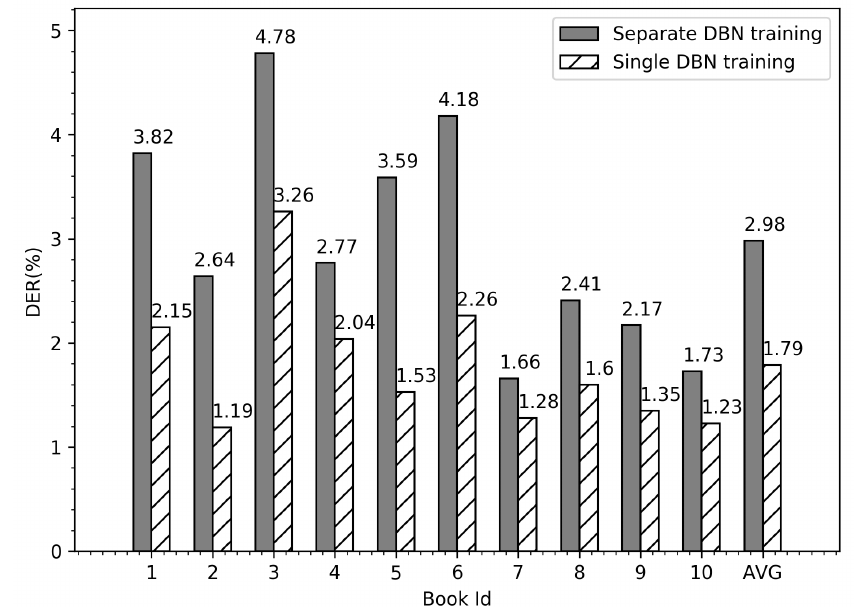
Figure 8. DER results for separate DBN and single DBN training of